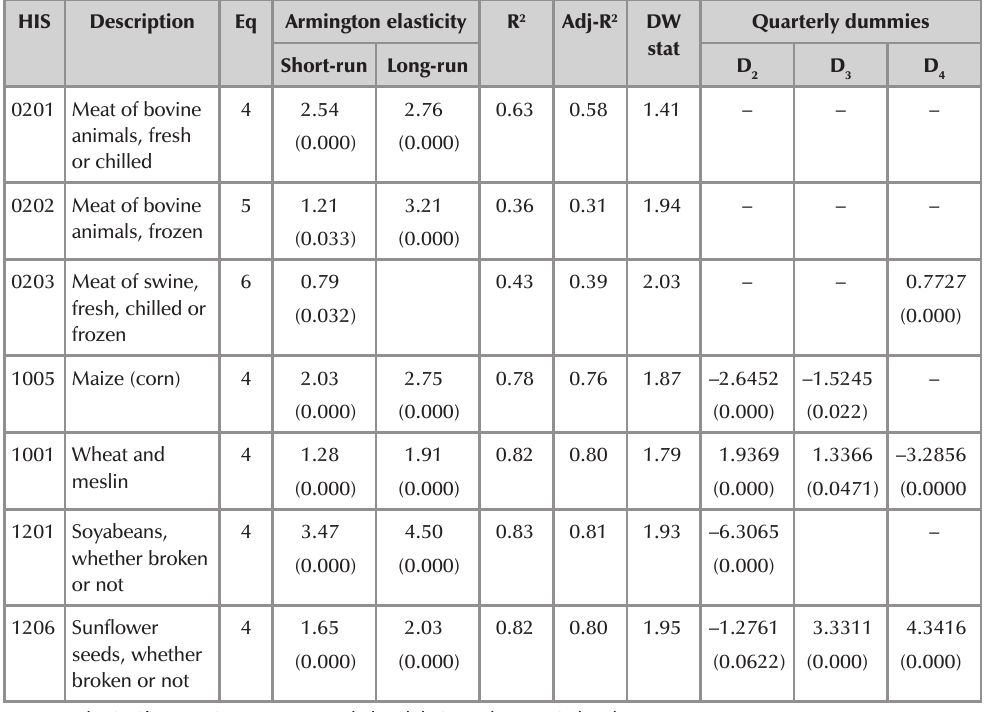
Short- and long-run Armington elasticities estimates for agricultural products in South